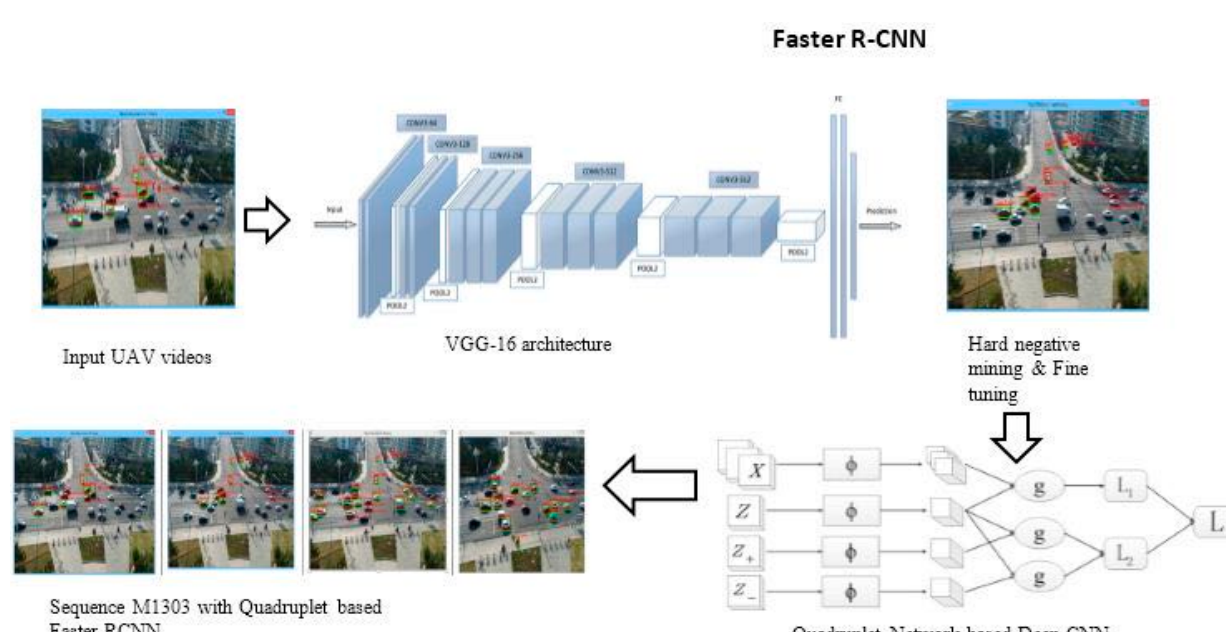
Figure 1. Quadruplet network-based faster region-based convolutional neural network (RCNN) architecture. The unmanned aerial vehicle (UAV) videos are fed into the novel generated image G-16 (VGG-16) network model. At this stage, the hard negative mining were fine-tuned and moved to the quadruplet network based Deep CNN. Finally, the resulting output is shown in sequence M1303 benchmark.